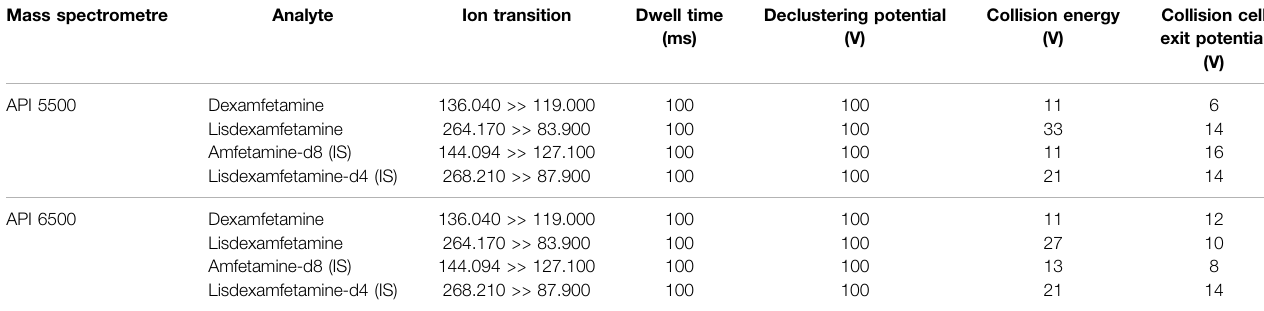
TABLE 1 | Optimal positive ions mass spectrometric conditions for multiple reaction